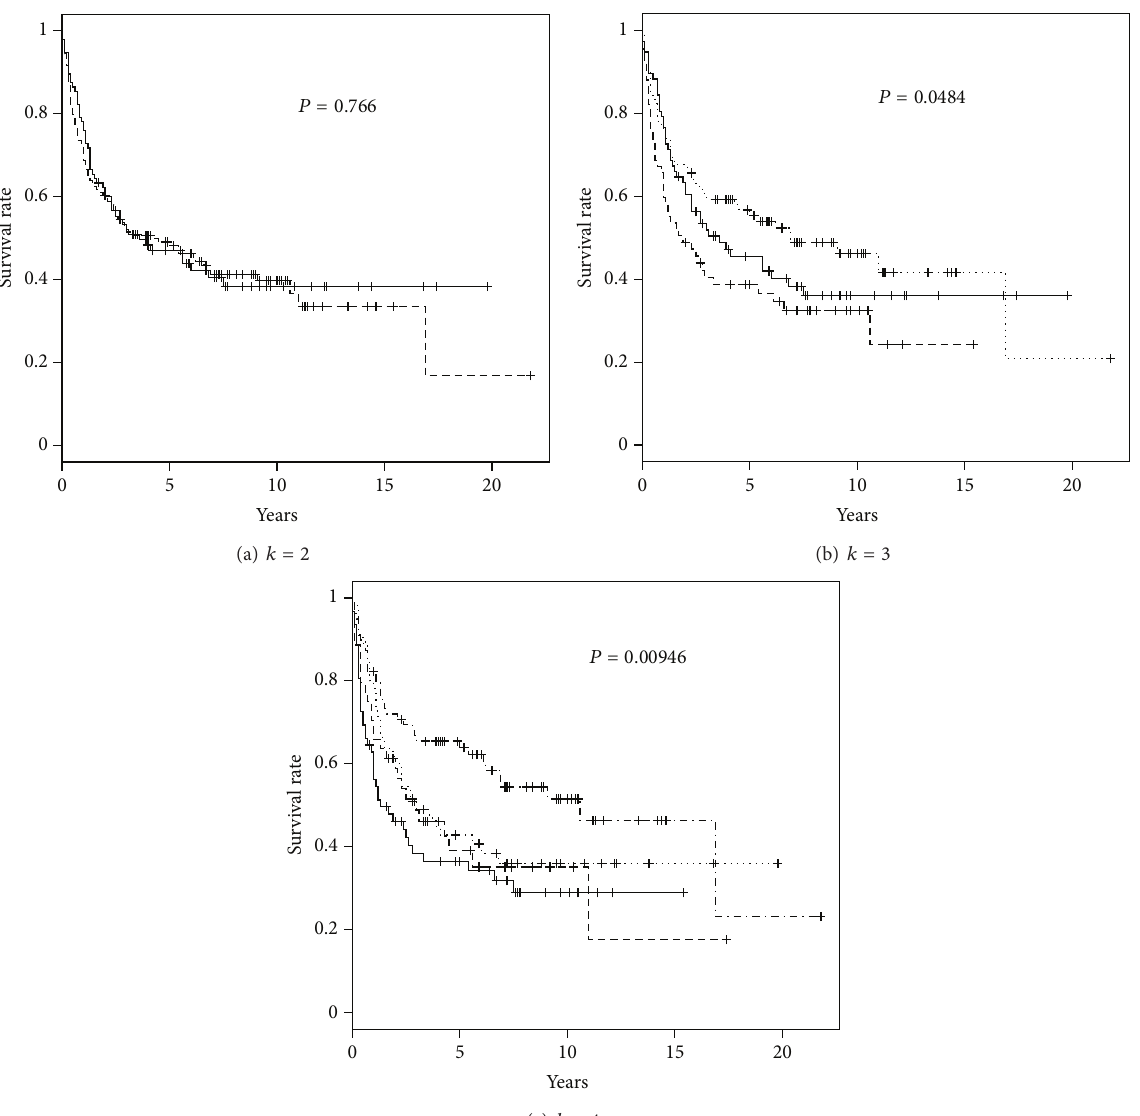
Figure 2: The Kaplan-Meier curve results of three kinds of patients’ divisions corresponding to rank 𝑘 = 2, ...,4 .